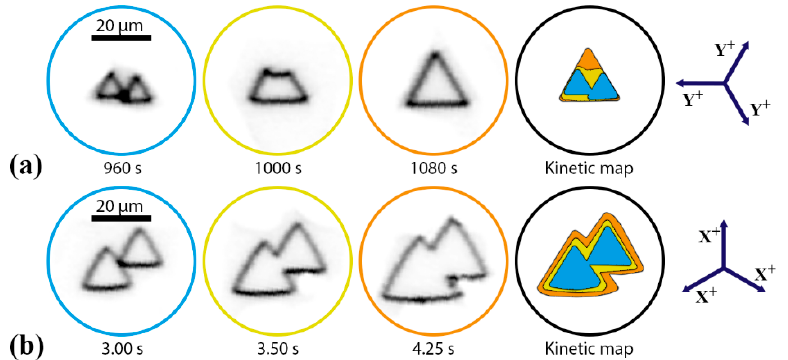
Figure 6. The domain wall images and kinetic maps for domain merging: ( a ) in low field, demonstrating the shape stability effect, E ex = 3.75 kV/mm, and ( b ) in high field, demonstrating the independent domain growth after merging, E ex = 12.50 kV/mm.